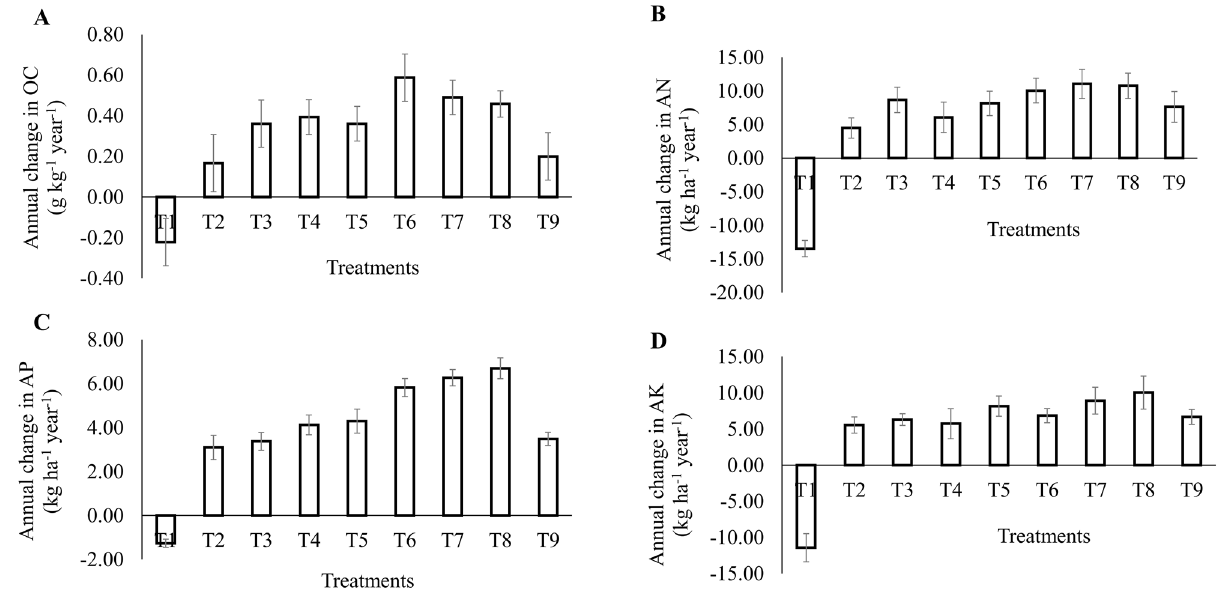
Figure 1. Annual change in organic carbon ( A ), available N ( B ), available P ( C ), and available K ( D ) as affected by bio-priming and mineral fertilization. Error bars indicate mean ± SE ( n = 3). Treatments: T 1 : Absolute control N:P 2 O 5 :K 2 O @ 0:0:0 kg ha −1 ; T 2 : RDF of N:P 2 O 5 :K 2 O @ 120:60:60 kg ha −1 ; T 3 : 75% RDF + Trichoderma harzianum ; T 4 : 75% RDF + Pseudomonas fluorescens ; T 5 : 75% RDF + Bacillus subtilis ; T 6 : 75% RDF + T . harzianum + P . fluorescens ; T 7 : 75% RDF + P . fluorescens + B . subtilis ; T 8 : 75% RDF + T . harzianum + B . subtilis ; T 9 : 75% RDF + T . harzianum + P . fluorescens + B . similar P uptake. Except for control, the uptake was found to increase in all the treatments during the second year over 1 st year. In the case of K, a significant increase in uptake (head and total) was recorded in T 6 treatment (Table S3). The magnitude of the increase due to this treatment over 100% RDF (T 2 ) was 31% (head) and 21% (total). However, applying 100% chemical fertilizers and combined use of chemical fertilizers and bio-agents did not significantly differ in the uptake of macronutrients by the stalk. In general, the K uptake varied from 8.25 to 57.35 kg ha −1 for the head and 16.64–22.15 kg ha −1 for the stalk. Stalk K uptake was highest (22.15 kg ha −1 ) in the first year with 75% RDF + B . subtilis (T 5 ). The total K uptake ranged from 29.03 to 78.20 kg ha −1 in the first year and 26.08–78.51 kg ha −1 in the second year. During the second year, the total K uptake of plants under 100% RDF was par with single- and triple-priming treatments. Among single- and triple-priming treatments, the highest total K uptake was observed with the application of 75% RDF + P . fluorescens (T 4 ) during both years. The lowest N, P, and K uptake were recorded from the control (T 1 ) plots. On average, red cabbage removed macronutrients in the order of K (64.32 kg ha −1 ) > N (55.05 kg ha −1 ) > P (8.91 kg ha −1 ). The higher nutrient uptake in the inte- grated application of chemical fertilizers and bio-agents is explained by developing proliferous root systems in bio-primed plants and increased microbial activity in the soil, which helped mineralize nutrients maintaining the soil solution greater assimilation in plants. Several workers 25–31 reported increased nutrient uptake in crops due to the combined application of chemical fertilizers (reduced level) and biofertilizers. Annual change in organic carbon (OC) and available N, P, and K. A positive annual change in OC (Fig. 1) was noted for all the treatments (T 2 -T 9 ) except in control plots (T 1 ) which showed a negative change of − 0.22 g kg −1 year −1 . The highest positive change was documented under 75% RDF + T . harzianum + P . fluo‑ rescens (T 6 , 0.59 g kg −1 year −1 ) followed by 75% RDF + P . fluorescens + B . subtilis (T 7 , 0.49 g kg −1 year −1 ), and the lowest was recorded under 100% chemical fertilization (T 2 ) being 0.17 g kg −1 year −1 which was at par with 75% RDF + T . harzianum + P . fluorescens + B . subtilis (T 9 , 0.20 g kg −1 year −1 ). In the case of annual change of available N, P, and K, similar trends were noticed as OC (Fig. 1). However, the highest and lowest changes varied. Applica- tion of 75% RDF + P . fluorescens + B . subtilis (T 7 ) and 75% RDF + T . harzianum + B . subtilis (T 8 ) demonstrated (Fig. 1) higher positive changes in available N (11.06 and 10.06 kg ha −1 year −1 , respectively), while 100% RDF (T 2 ) showed the lowest change (4.47 kg ha −1 year −1 ). The control plots (T 1 ) showed a significant negative annual change in available N (− 13.46 kg ha −1 year −1 ) after crop harvest. The T 8 treatment showed the maximum positive annual change (6.70 kg ha −1 year −1 ) followed by T 7 (6.27 kg ha −1 year −1 ) for available P (Fig. 1). However, the least positive change in available P was evident in T 2 (3.10 kg ha −1 year −1 ), which was at par with the treatment T 9 (3.48 kg ha −1 year −1 ). A negative change of − 1.27 kg ha −1 year −1 in available P was observed in T 1 plots. There were no significant positive annual changes observed between the treatments for available K (Fig. 1). However, the T 8 treatment presented the highest positive annual change value of 10.04 kg ha −1 year −1 , followed by T 7 (8.92 kg ha −1 year −1 ); the rest of the treatments (T 2 , T 3 , T 4 , T 5 , T 6 , and T 9 ) documented at par values of the same. The T 1 plots recorded a significant negative annual change in available K (− 11.43 kg ha −1 year −1 ).